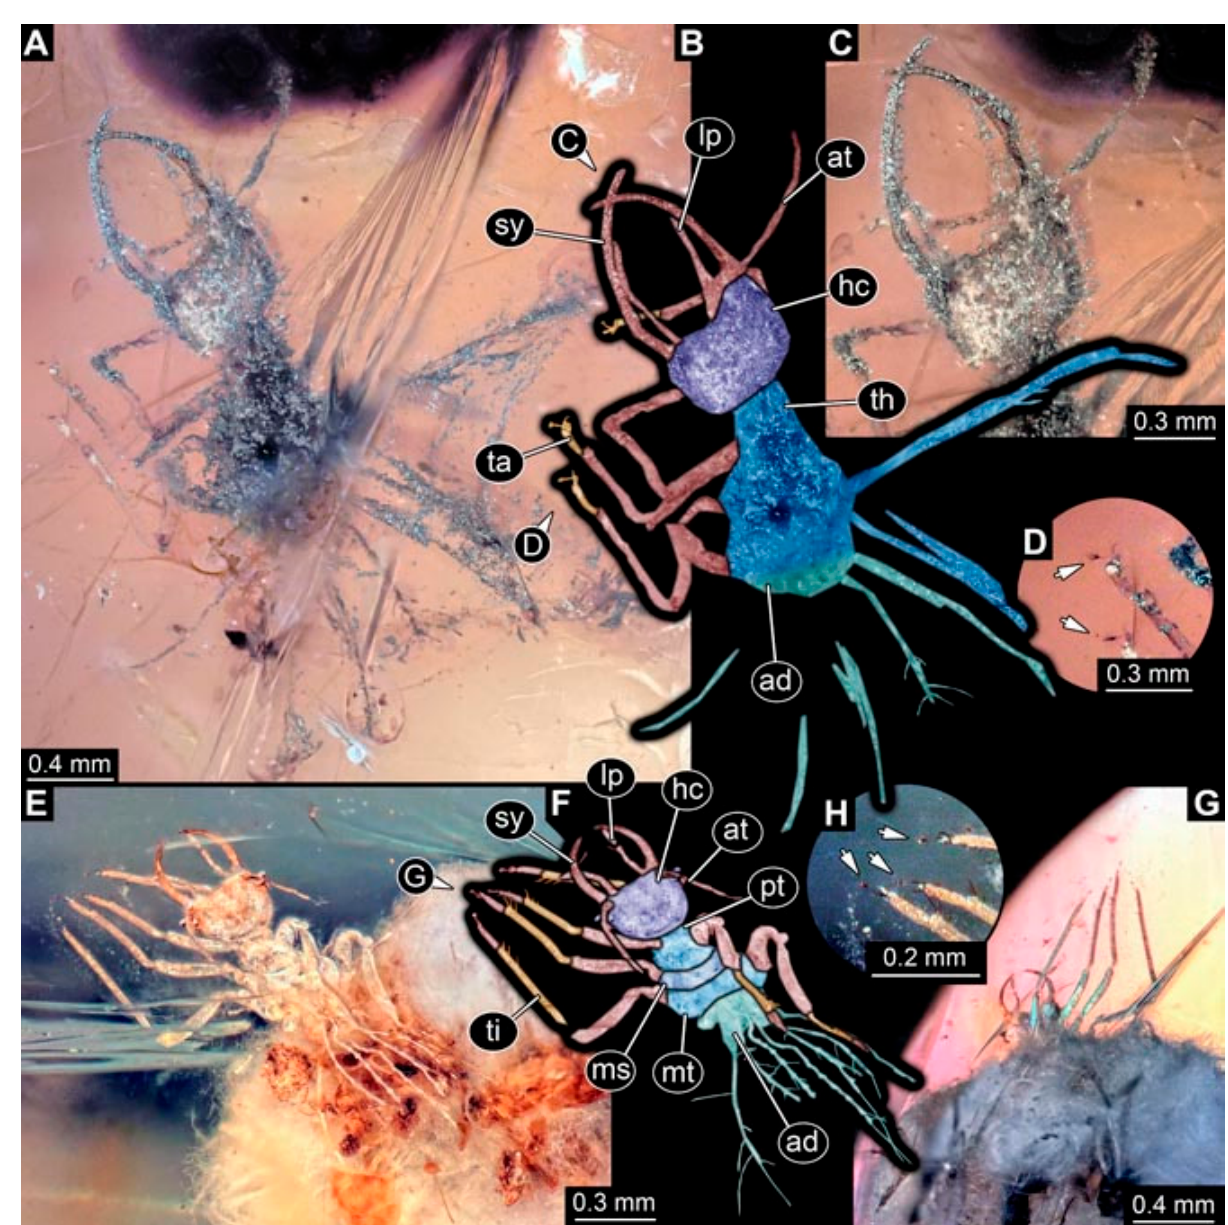
Figure 40. Two specimens in Myanmar amber. ( A – D ) Specimen 4869 (PED 1287). ( A ) Dorsal view. ( B ) Dorsal view, colour-marked. ( C ) Close-up of head capsule in dorsal view. ( D ) Close-up of trunk appendages with empodia (arrows). ( E – H ) Specimen 4871 (PED 1311). ( E ) Dorsal view. ( F ) Dorsal view, colour-marked. ( G ) Ventral view. ( H ) Close-up of trunk appendages with empodia (arrows). Abbreviations: ad = abdomen; at = antenna; hc = head capsule; lp = labial palp; ms = mesothorax; mt = metathorax; pt = prothorax; sy = stylet; ta = tarsus; th = thorax; ti = tibia. (51) Specimen 4870 (PED 1301) is preserved in Myanmar amber. It is accessible in a dorso-